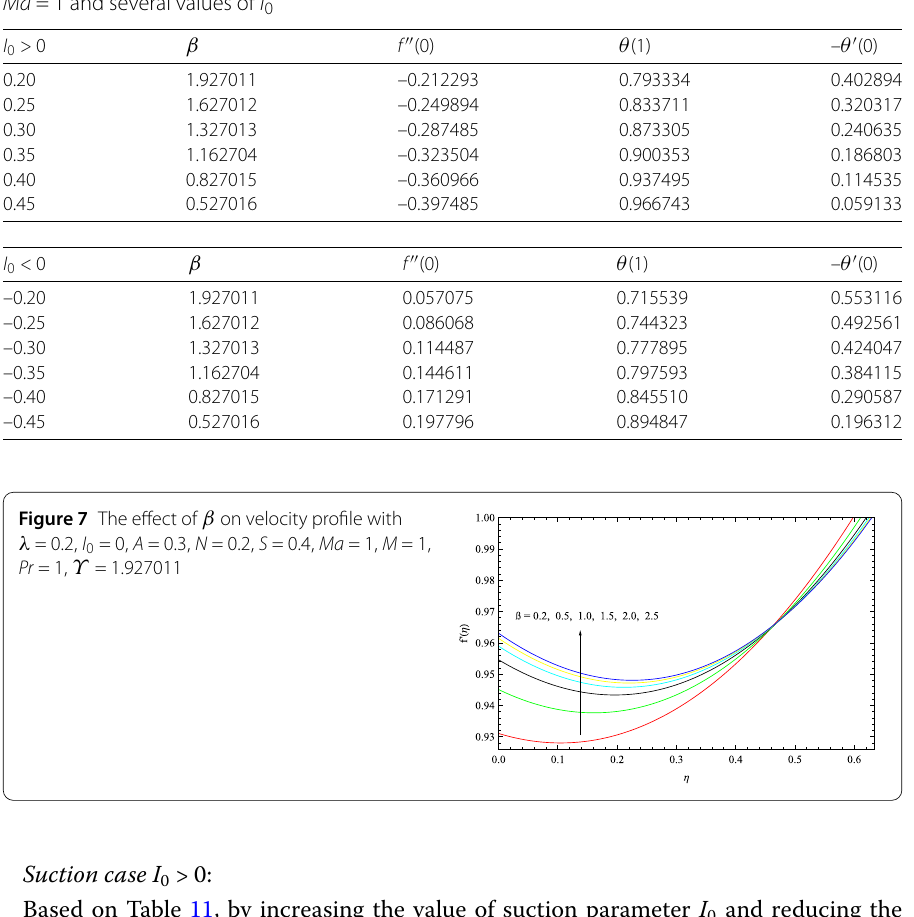
1 (cid:7)(cid:7) (0), θ (1), and – θ (cid:7) (0) using 20th-order HAM via Mathematica Table 11 Different values of β = Υ 2 , f package BVPh2.0 approximation for the case S = 0.4, β = 0.2, λ = 0.2, A = 0.3, N = 0.2, M = 1, Pr = 1,